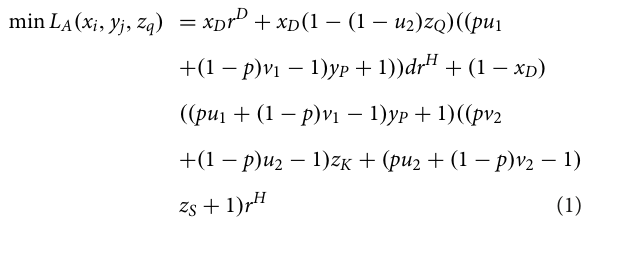
TABLE 1 Notations used in this